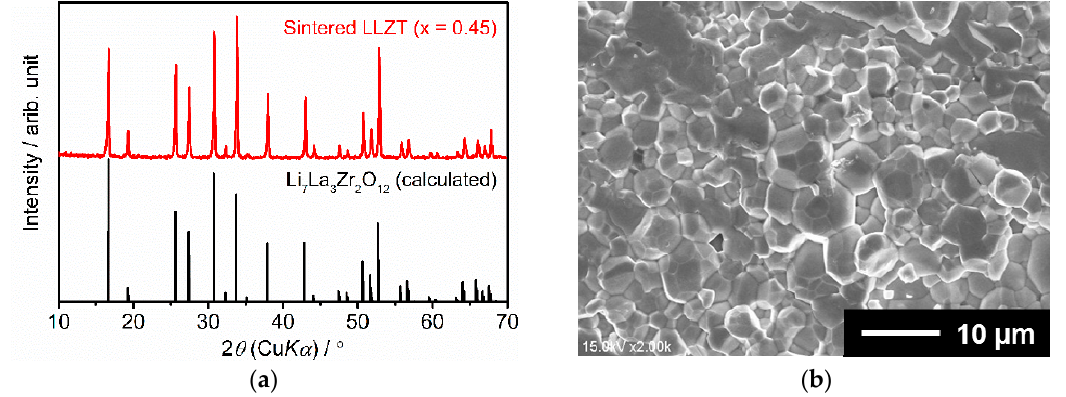
Figure 2. ( a ) X-ray diffraction (XRD) pattern and ( b ) scanning electron microscope (SEM) image of fractured cross section for sintered LLZT.